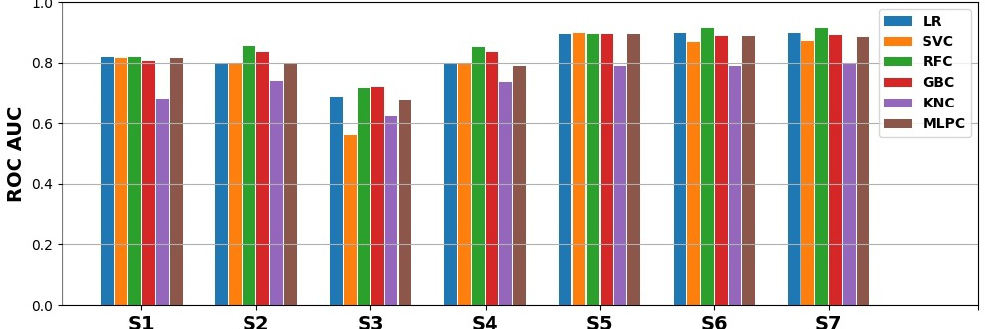
Figure 7. ROC AUC values for particular algorithms and attribute